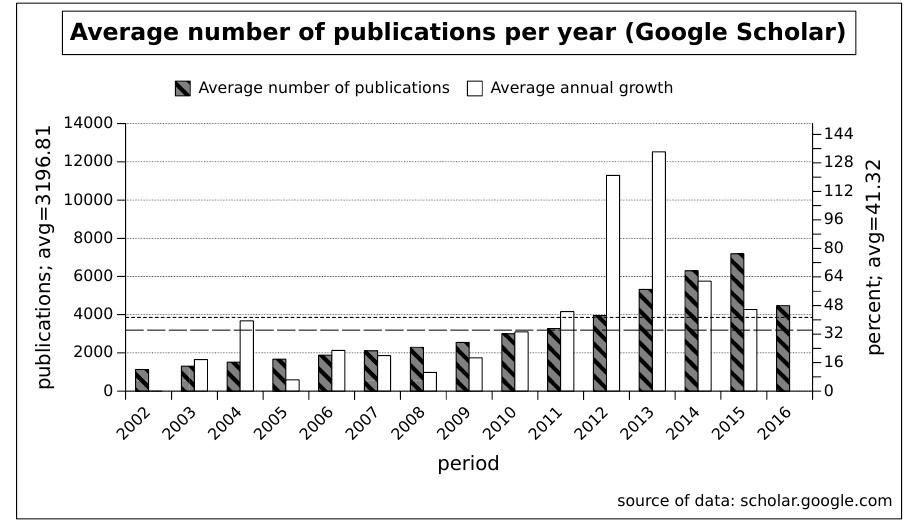
Figure 10. Average number of publications and annual average growth for the combined results from scholar.google.com for 2002–2016.